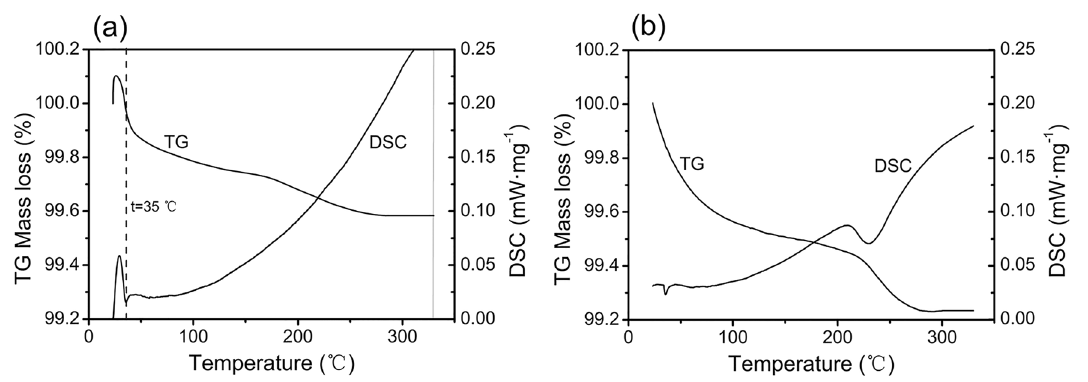
Figure 5: TG–DSC curves of ferrosilicon particles: (a) uncoated (b) coated